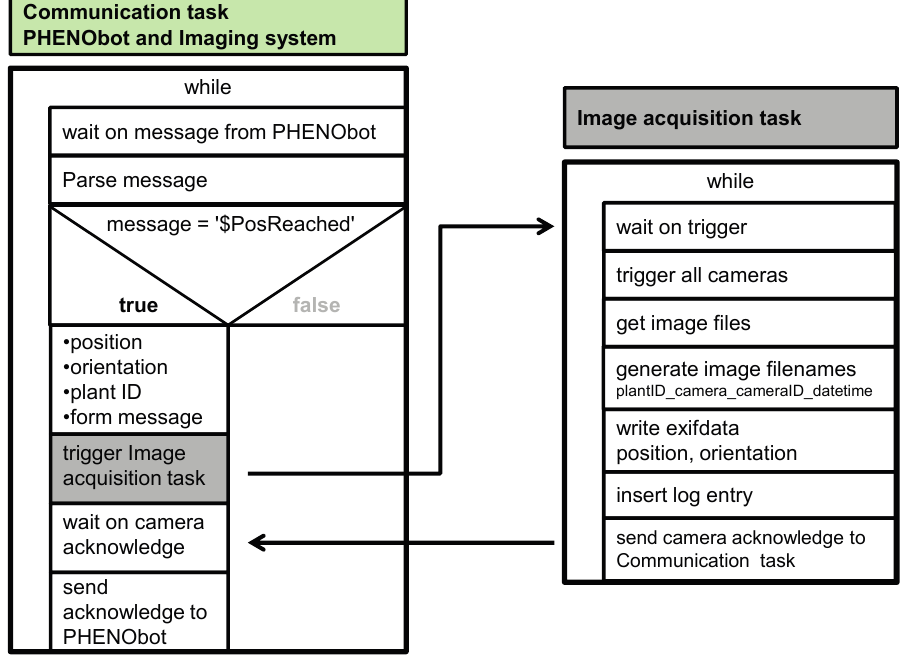
Figure 2. Communication and image acquisition task within the IggGeotagger.Ext software. The communication task handles the communication between the control unit of the PHENObot and the image acquisition PC; the image acquisition task controls the cameras and the image transport and